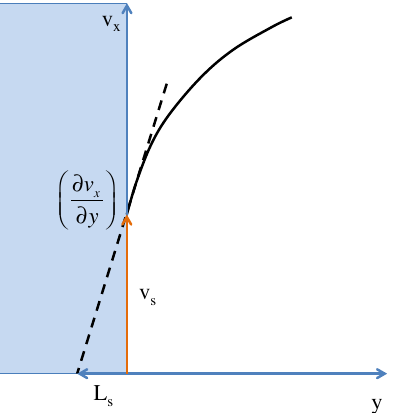
Figure 1. Schematic diagram showing the flow geometry for the definition of the slip length. The magnitude of the velocity gradient in the fluid at the wall is equal to v s / L s where L s is the magnitude of the slip length. Here, we have ∆ v x = v x stationary